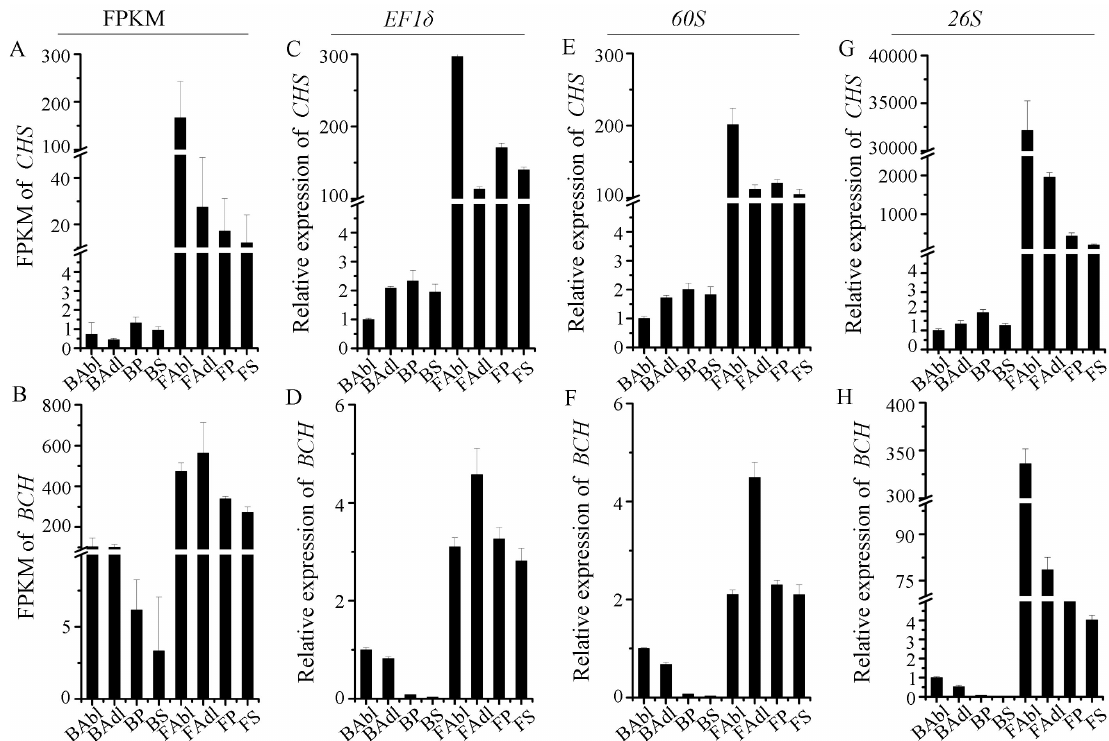
Figure 5. The expression profiles of CHS and BCH in C. lowianum. ( A , B ) The expression levels of CHS and BCH presented by FPKM value of transcriptome data. ( C – F ) The expression levels of CHS and BCH normalized by the most stable reference genes EF1 δ ( C , D ), and 60S ( E , F ). ( G , H ) The expression levels of CHS and BCH normalized by the most unstable reference genes 26S. BAbl, BAdl, BP, and BS indicate abaxial lip, adaxial lip, petal, and sepal of the bud, respectively. FAbl, FAdl, FP, and FS indicate abaxial lip, adaxial lip, petal, and sepal of the flower,